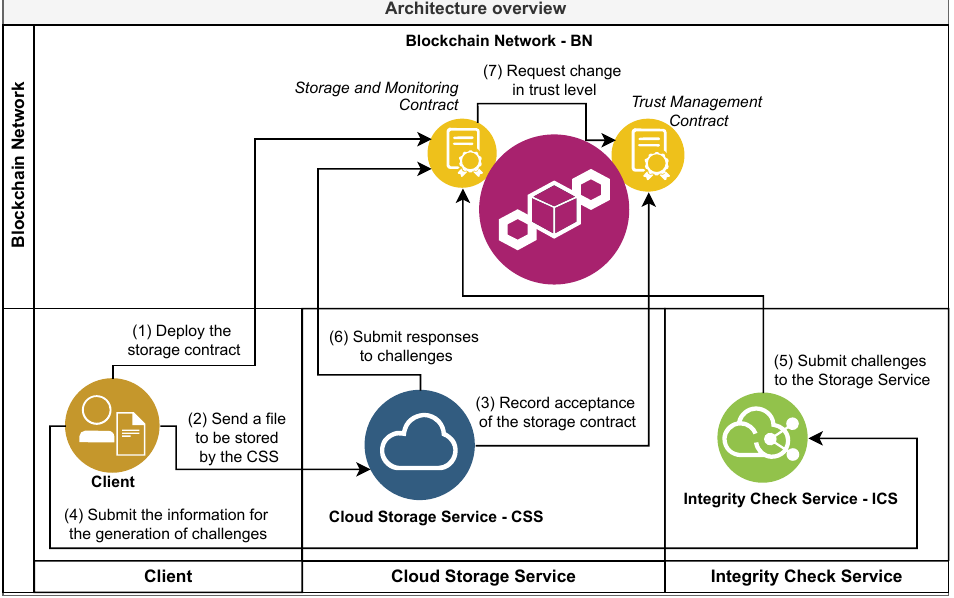
Figure 1. Architecture